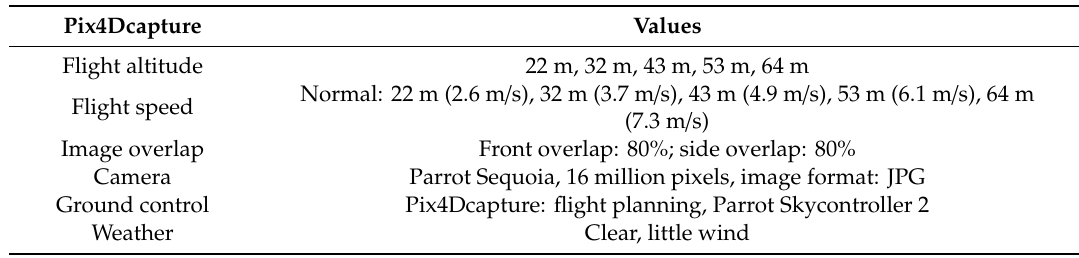
Table 1. Flight, camera, and ground control parameters.